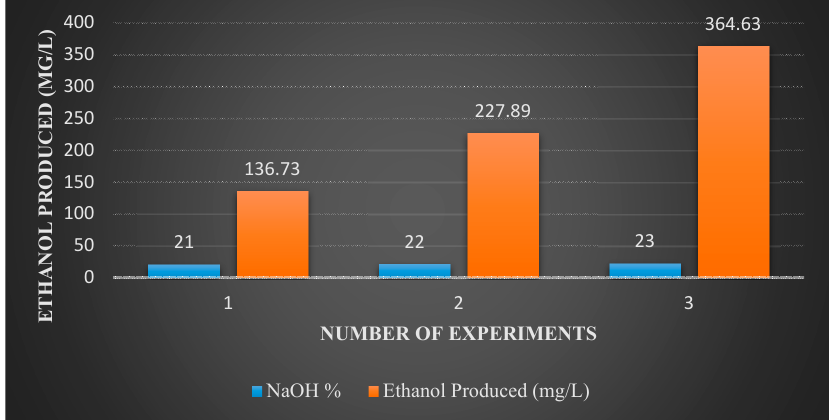
Figure 5. Ethanol production from NaOH pretreated bagasse.